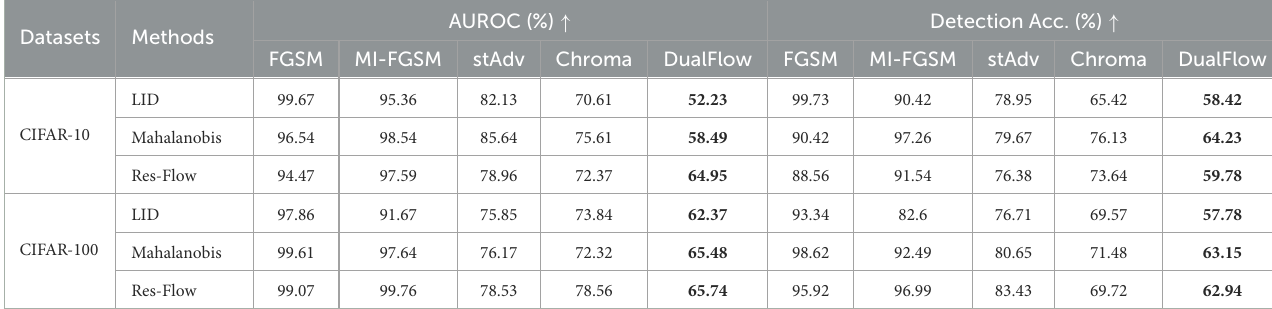
TABLE 7 The detect results of DualFlow and the baselines on CIFAR-10 and CIFAR-100, Where the Chroma represent the Chroma-Shift.